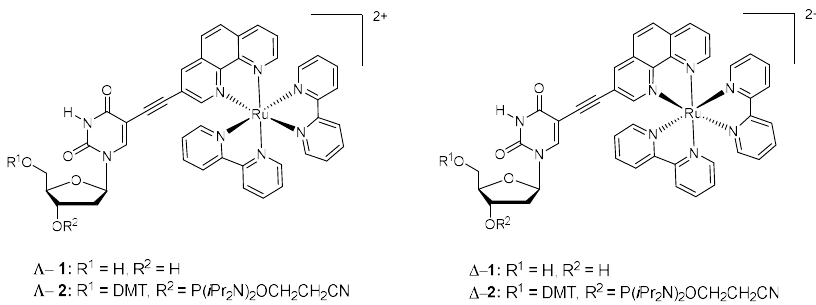
Figure 5. Chemical structures of the nucleosides containing the diastereomer Λ- 1 and Δ- 1 and their corresponding phosphoramidites (Λ- 2 and Δ- 2 ).